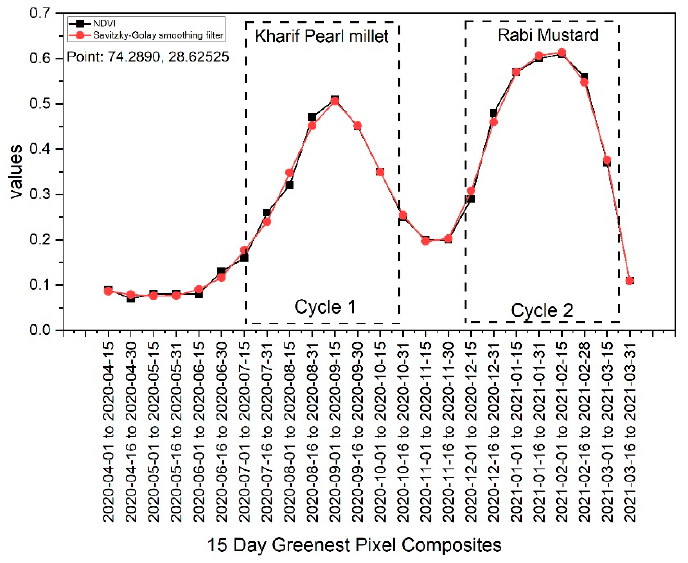
Figure 6. Double crop time series NDVI signature.